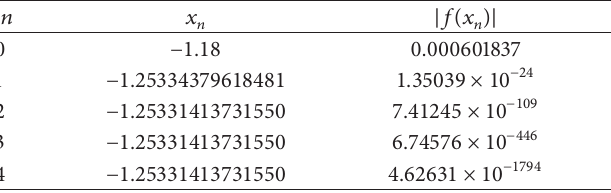
Table 4: Convergence behavior with 𝑓(𝑥) = (1 − sin (𝑥 2 ))( log (2𝑥 2 − 𝜋 + 1)) 4 , (𝑚, 𝜆,𝜌) = (6, 1,−1) , 𝛼 = −√𝜋/2 .